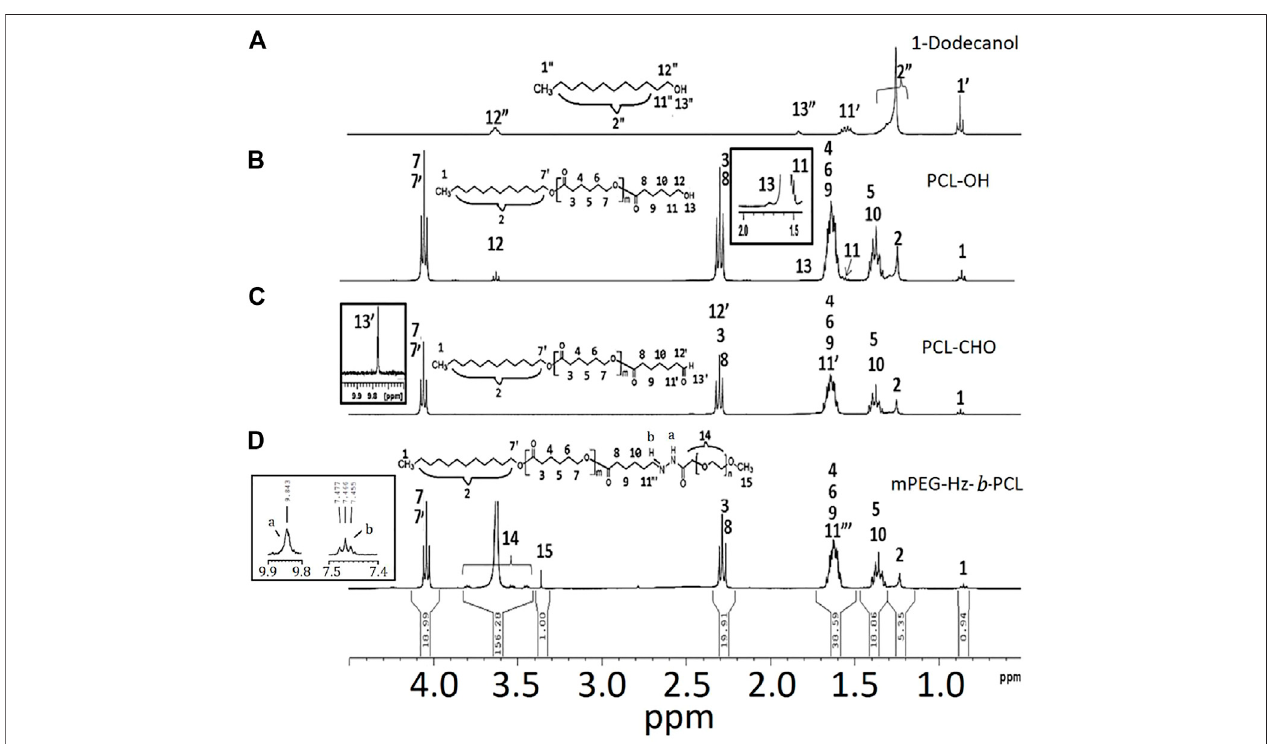
FIGURE 1 | 1 H NMR spectrum of the samples: (A) 1-dodecanol, (B) PCL-OH, (C) PCL-CHO, and (D) mPEG-Hz- b -PCL.